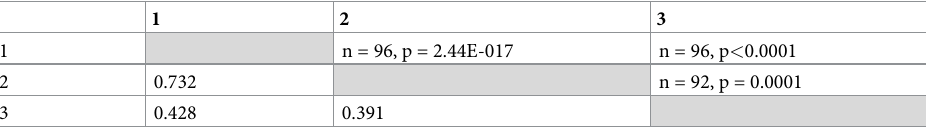
Table 4. Fecal microbiota α diversity is highly correlated between collections.